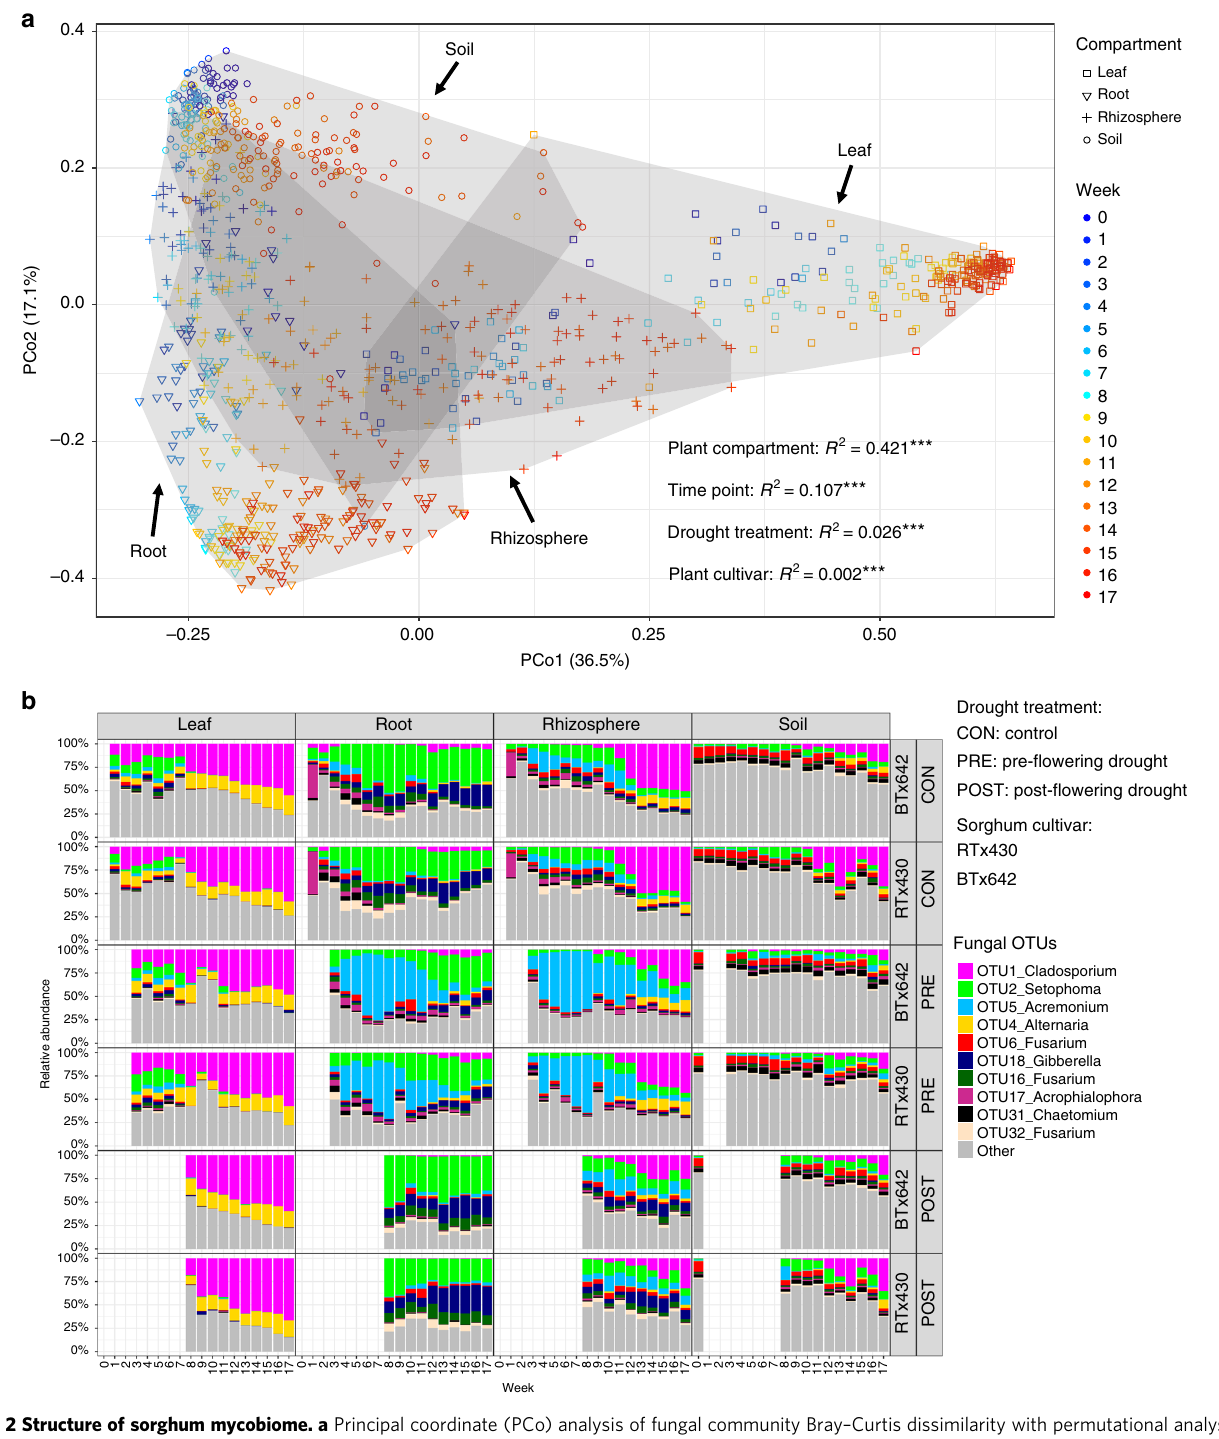
Fig. 2 Structure of sorghum mycobiome. a Principal coordinate (PCo) analysis of fungal community Bray – Curtis dissimilarity with permutational analysis of variance (PERM ANOVA) showing signi fi cant association of fungal community composition with, in order of importance, compartment, time point (TP), drought treatment and sorghum cultivar (*** P < 0.001). Note that results of principal component (PC) analysis of Aitchison distance is presented in Supplementary Fig. 5. b Temporal change in relative abundance of fungal operational taxonomic units (OTUs) at each TP in the four compartments, three treatments and two sorghum cultivars. To avoid redundancy, pre- fl owering treatment sampling began at the third week and post- fl owering sampling began at the 8 th week. Source data are provided as a Source Data fi